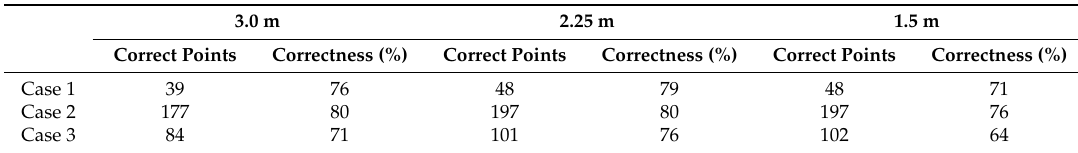
Table 3. The analysis of threshold T 2